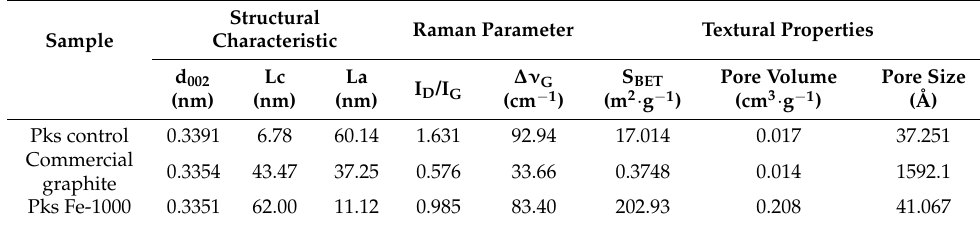
Table 2. Physical properties of synthesized graphitic carbon, commercial graphite and control sample.